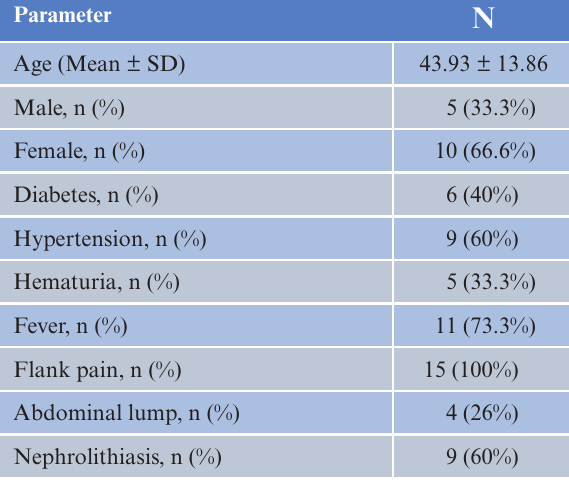
Table 1: Clinical parameters of patients.